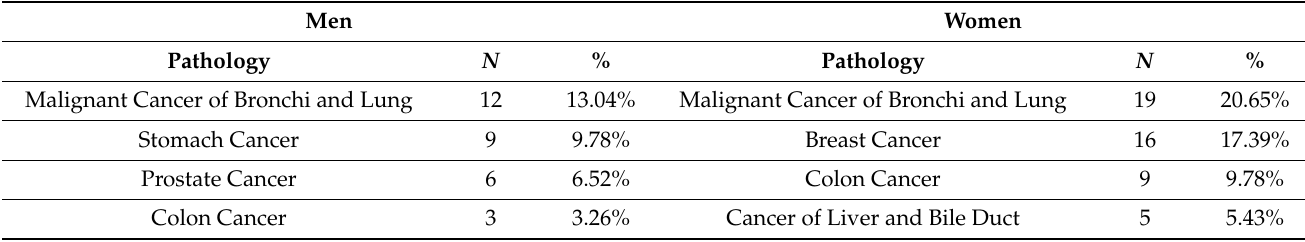
Table 2. Main patient